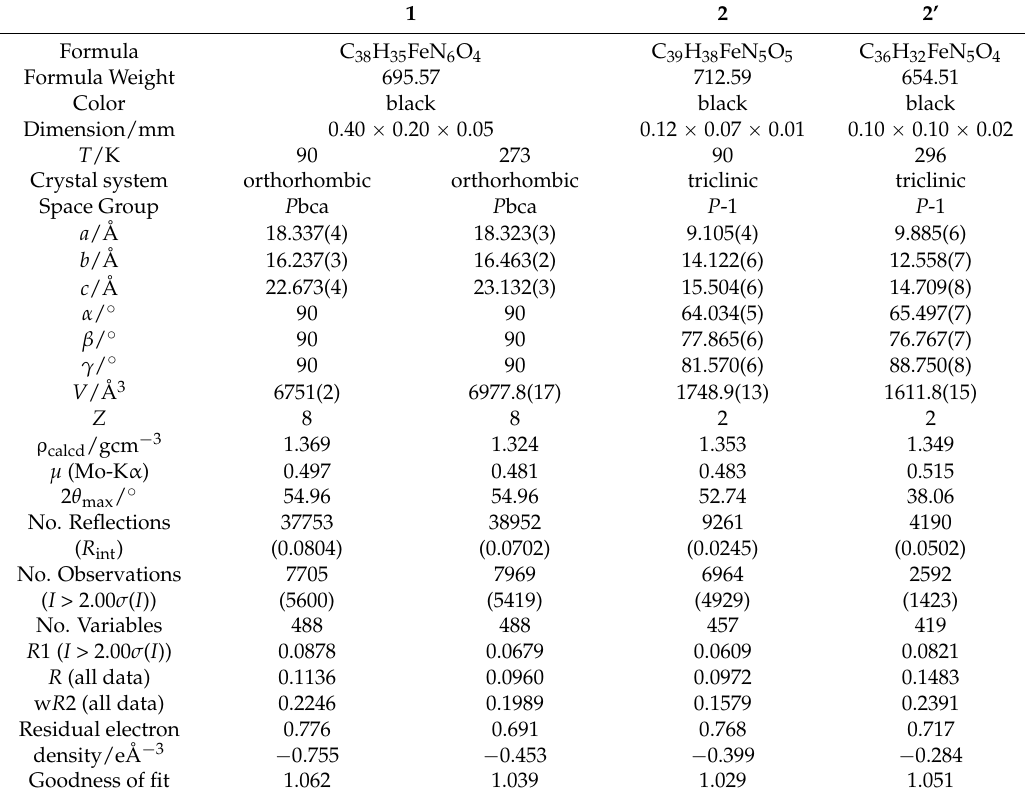
Table 2. Crystallographic data for 1 and 2